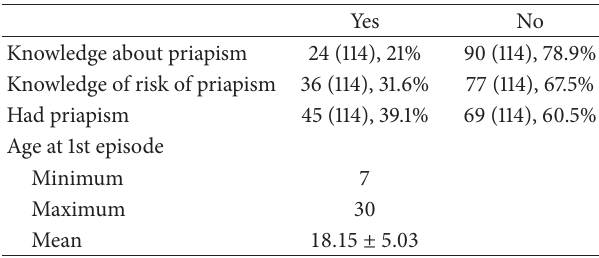
Table 2: Assessment of knowledge/prevalence about